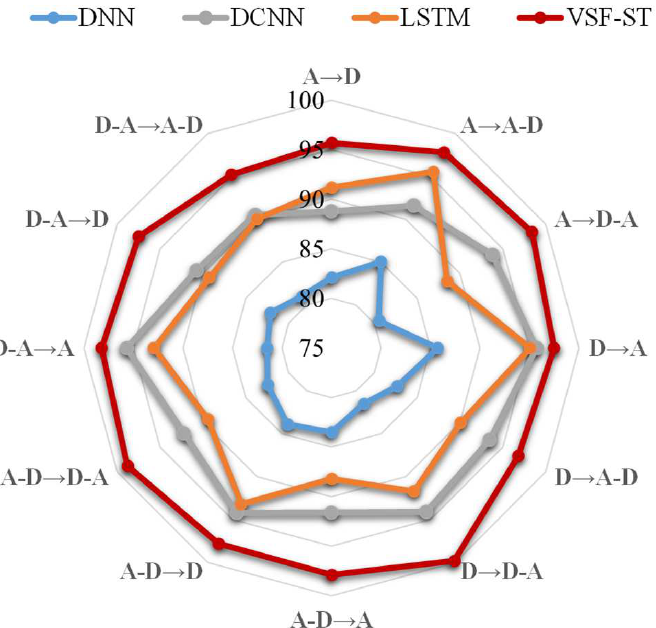
Figure 13. Comparison experiment of variable-speed cross-domain diagnosis classification based on the University of Ottawa